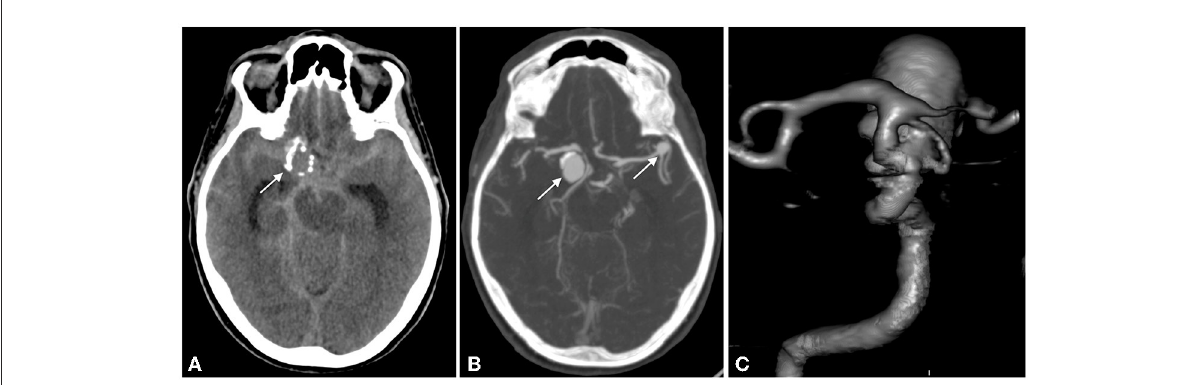
FIGURE1 NCCT: subarachnoid hemorrhage in the basal and sylvian cistern > 1mm thick and in the 4 th ventricle; a round mass with peripheral calcification is seen (white arrow) (A) ; CTA and VRT display 2 aneurysms, one on the right supraclinoid ICA, the second on the left MCA bifurcation (white arrows) (B,C) .